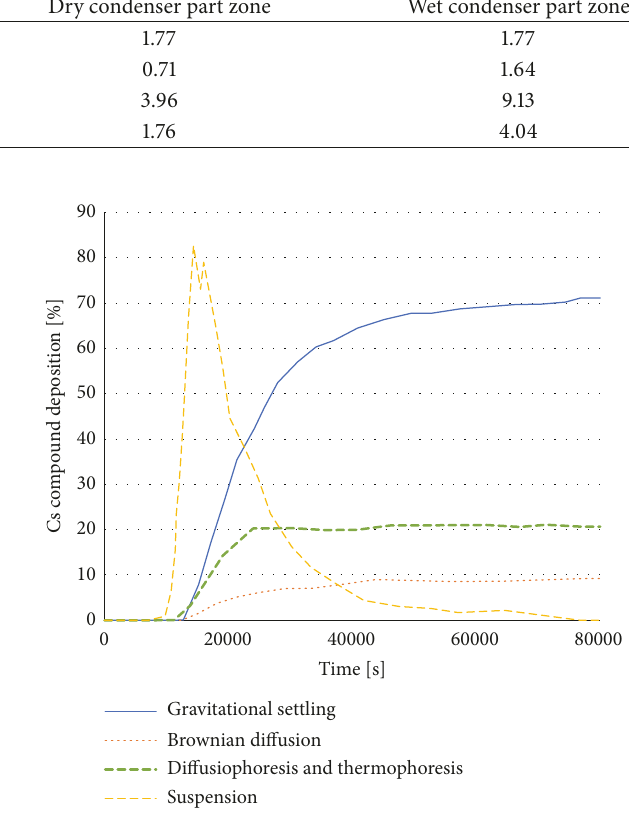
Figure 11: Ph´ebus FPT3 calculated results using deposition kinetic models [7,